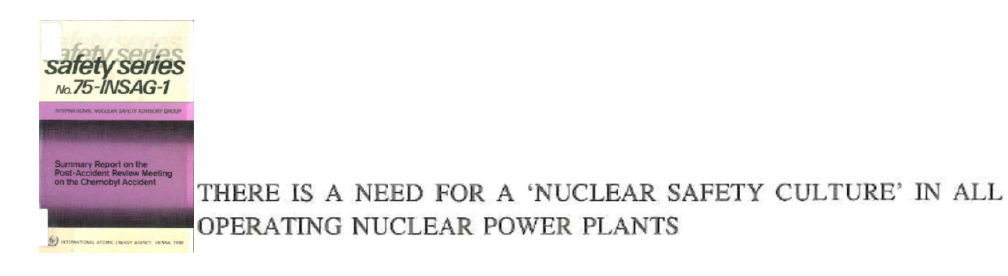
Figure 1. The concept of safety culture was introduced in 1986 in the summary report of the post- accident review meeting on the Chernobyl accident [1] (p. 76) (This cover image and sentence are used with permission from the International Atomic Energy Agency. No further use is allowed).